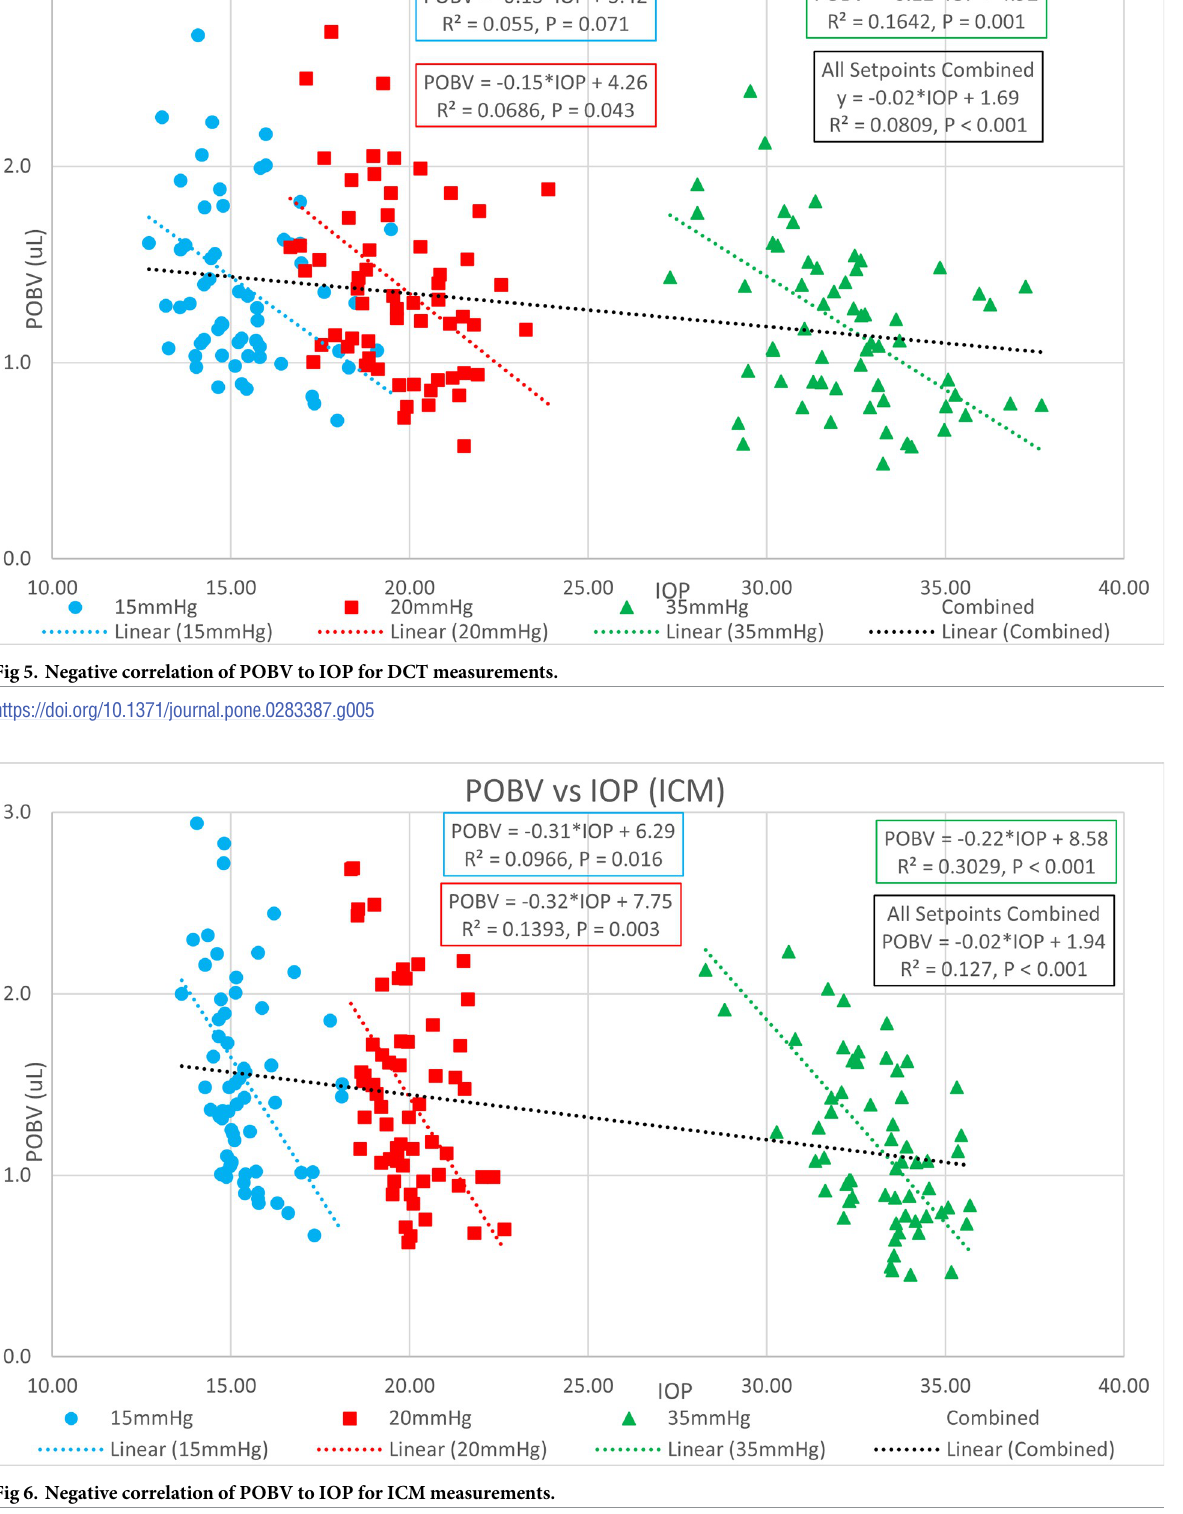
PLOS ONE | https://doi.org/10.1371/journal.pone.0283387 March 23,